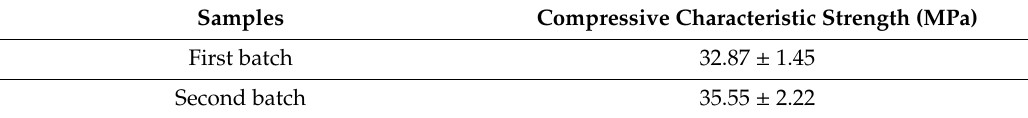
Table 4. Compressive characteristic strength for cylindrical test specimens (150 × 300 mm).